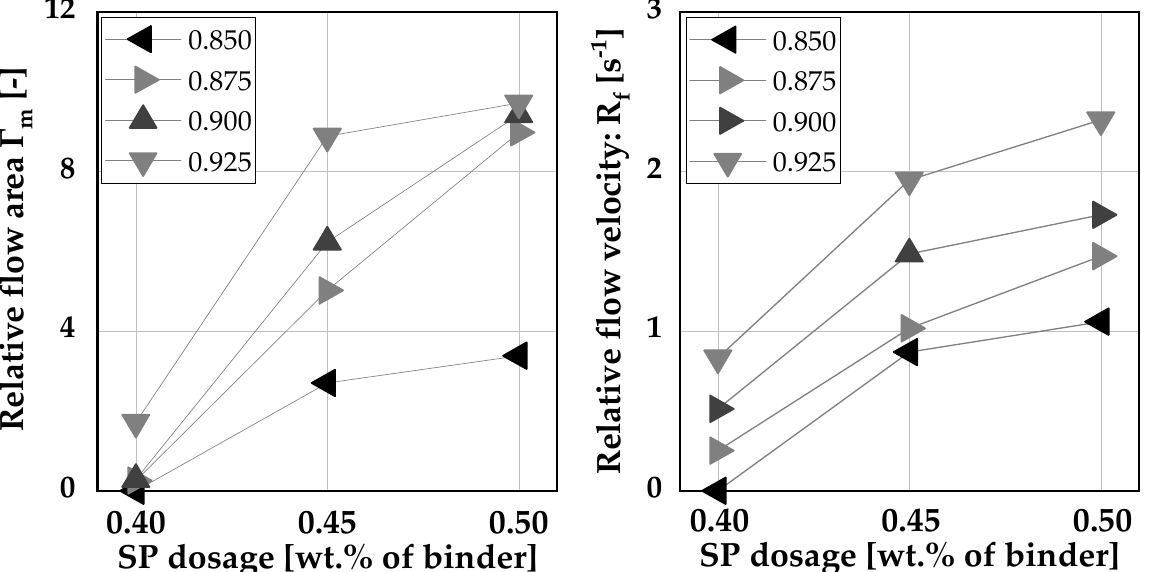
Figure 3. Influence of CC on the Γ m of SC-P.